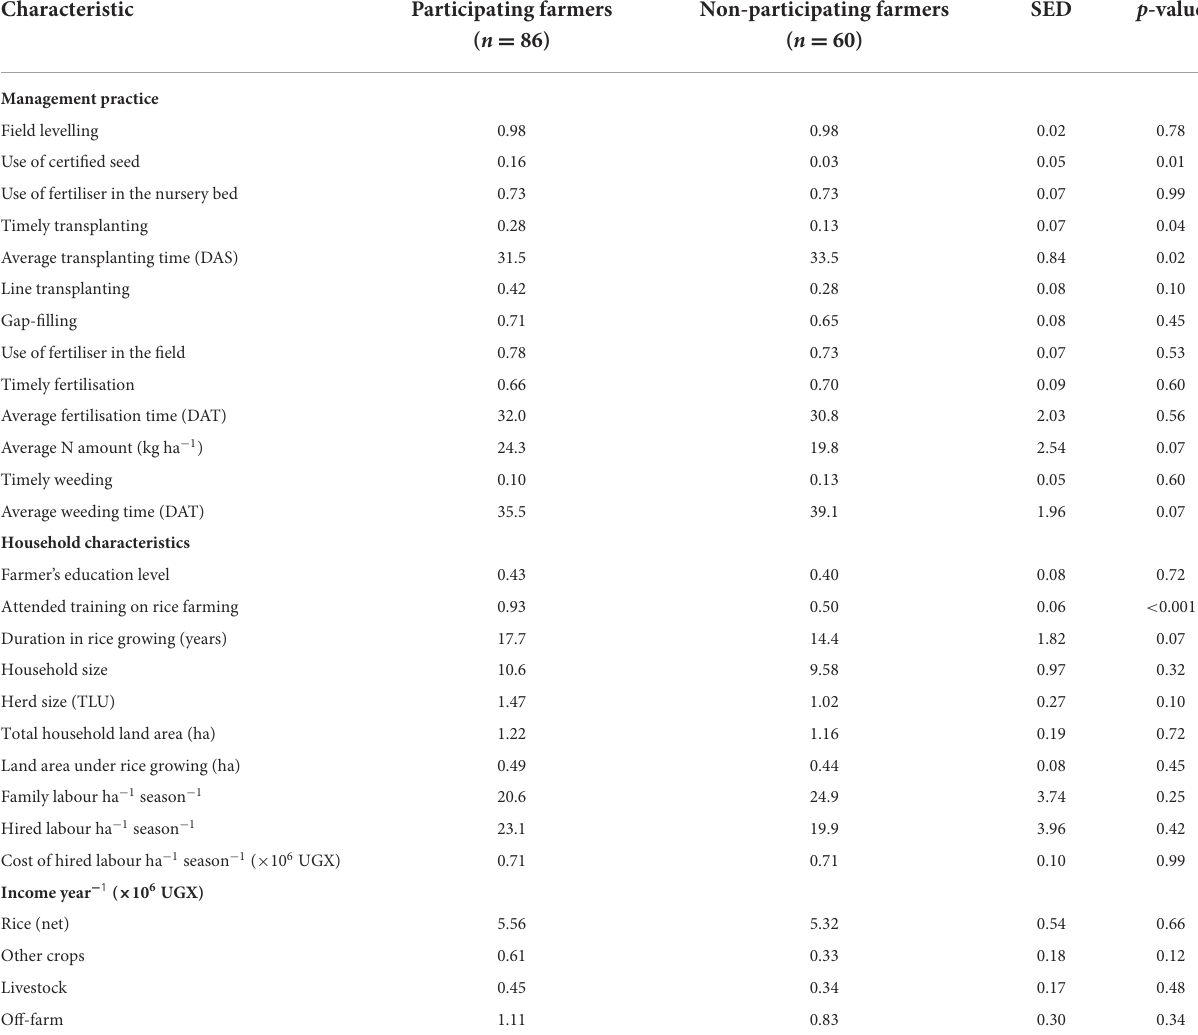
TABLE 5 Management practices and household socio-economic characteristics of participating and non-participating farmers, Doho rice irrigation scheme, Butaleja District, Uganda, 2021. Characteristic Participating